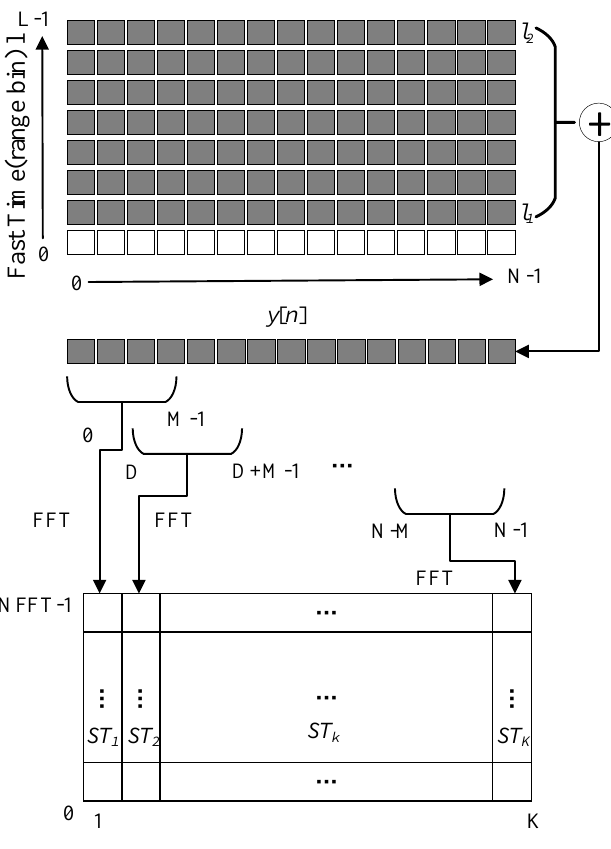
Figure 6. The flow of micro-Doppler